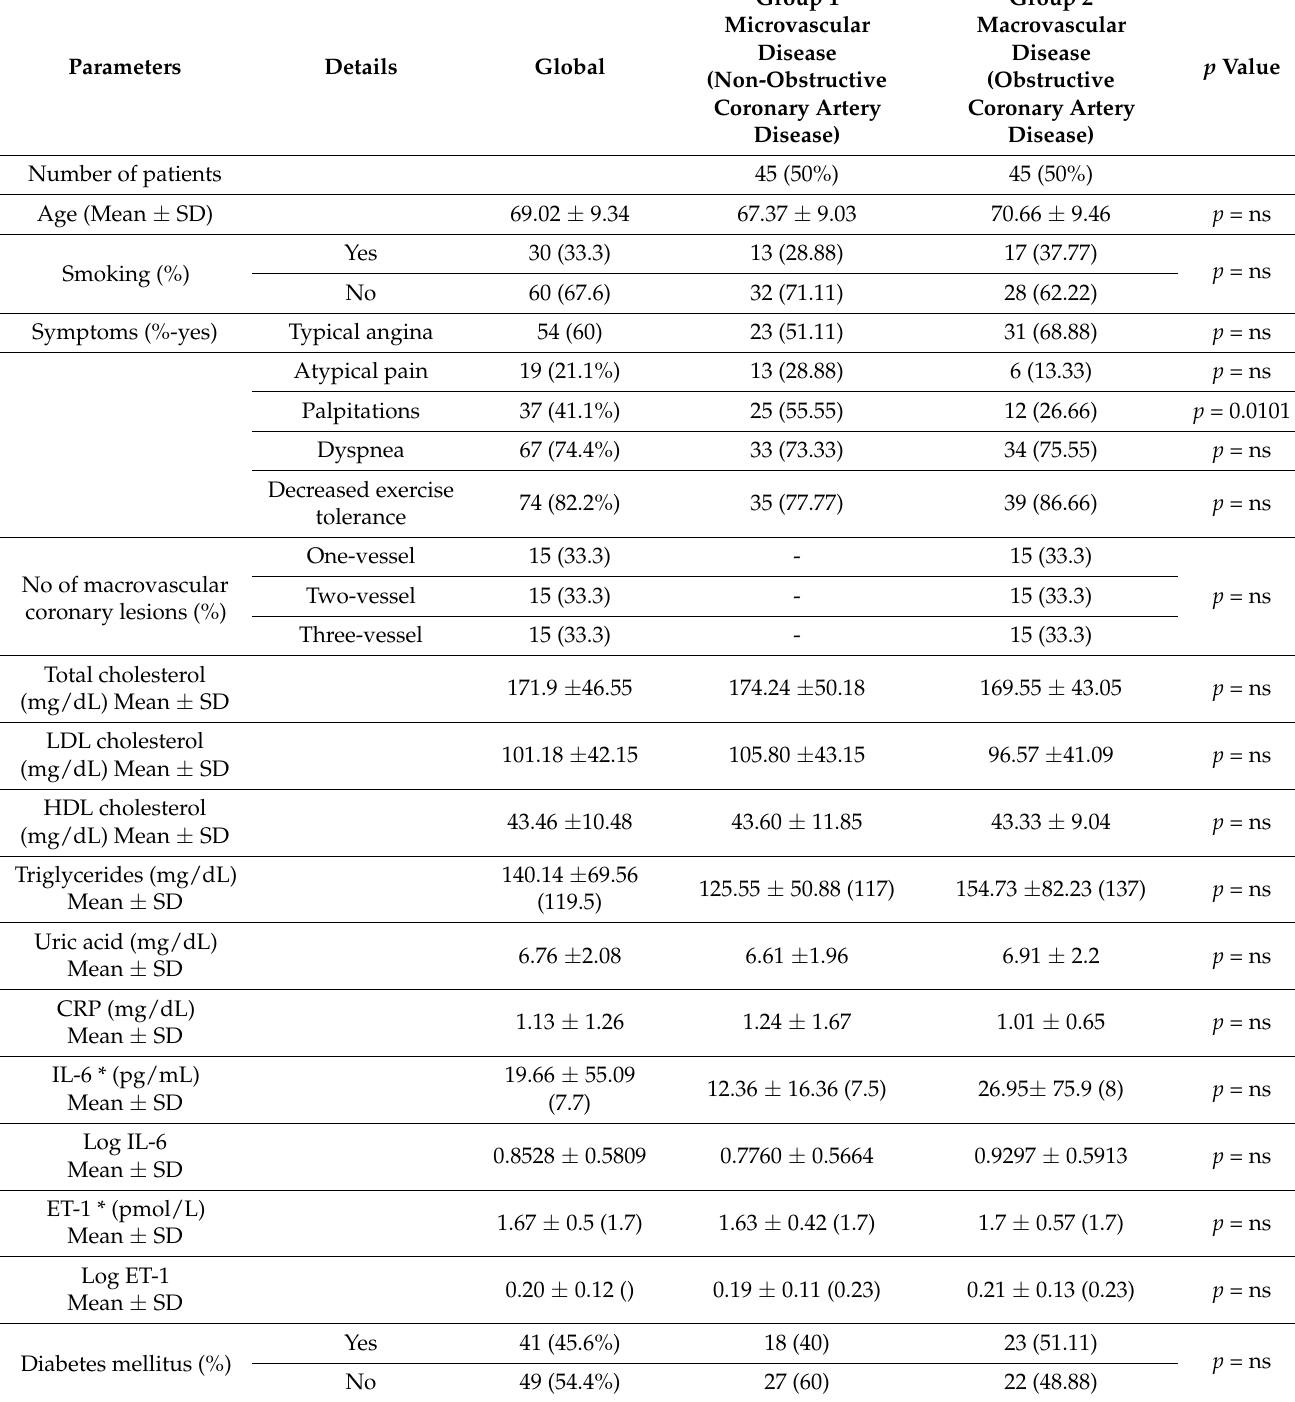
Table 1. Characteristics of the patients included in the